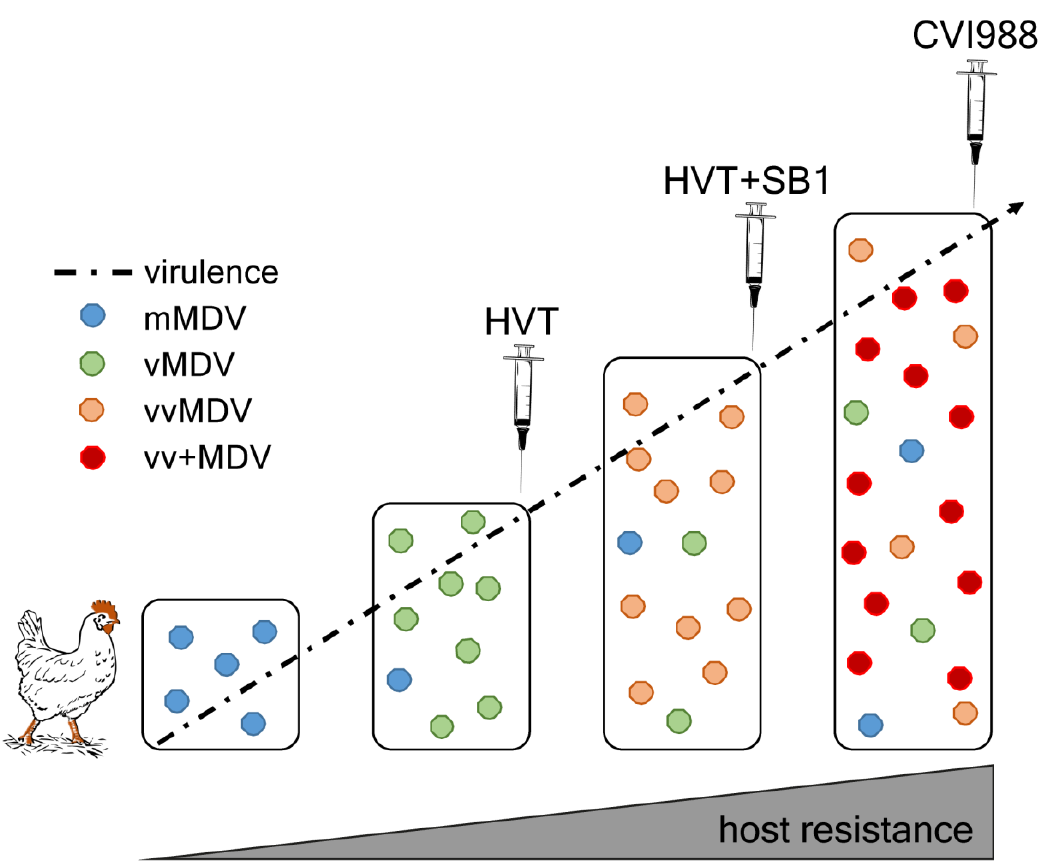
Figure 2. Increasing average virulence of MDV field strains and introduction of the different MDV vaccines over the past decades in the USA (HVT, herpesvirus of turkey; SB1, Gallid herpesvirus 3 strain; CVI988,non-oncogenic MDV strain). The HVT vaccine was launched in the 1970s, the bivalent HVT+SB1 in the late 1980s and the current CVI988 vaccine in the 1990s (USA)/1970s (Europe) [14]. Symbols represent the different MDV pathotypes: m (blue), v (green), vv (orange), and vv+ (red). At the same time, breeding programs focused on an increased resistance to MDV-induced tumorigenesis.